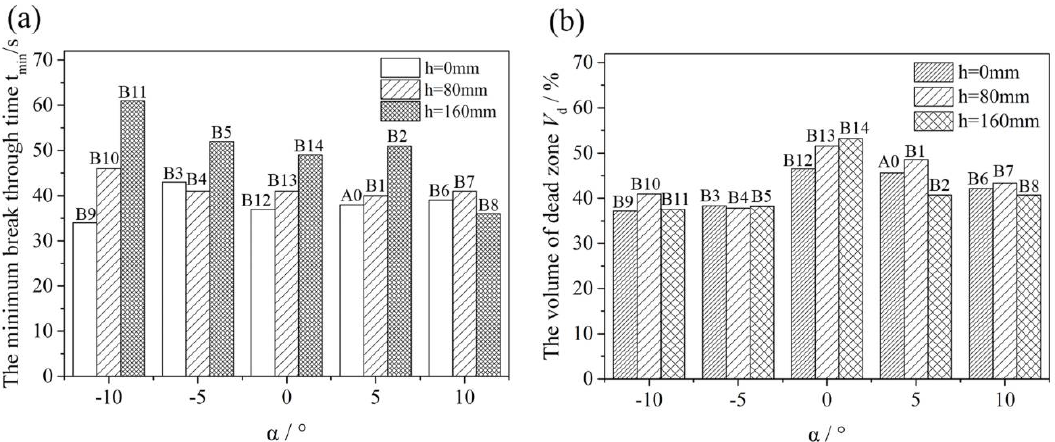
Figure 9. Comparison of the minimum break through time ( a ) and the volume of dead zone ( b ) in isothermal experiments.